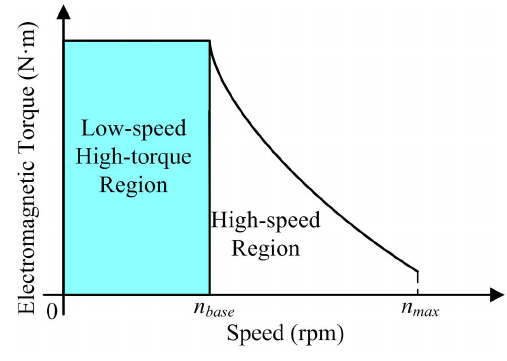
Figure 4. Torque-speed characteristic of